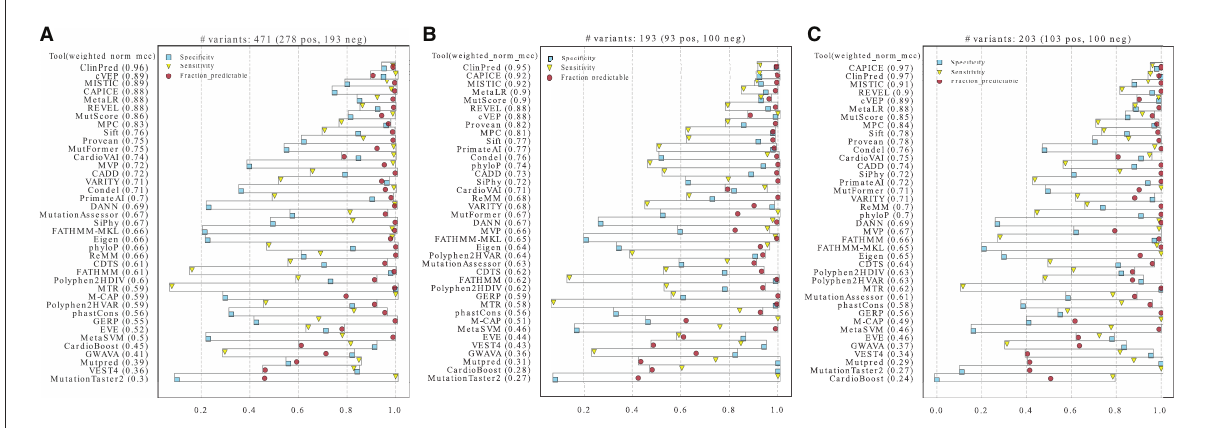
FIGURE3 Performance of prediction tools in classifying HCM missense variants using fixed thresholds for ClinVar (A) , SHaRe (B) and Walsh_2017 (C) datasets. For each dataset, the numbers of pathogenic/likely pathogenic (N pos) and benign/likely benign (N neg) variants are indicated. Tools were ranked according to the weighted normalized MCC